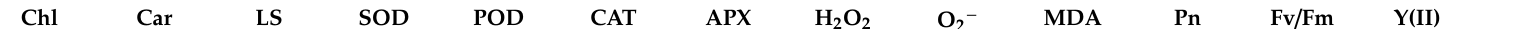
Table 4. Relationships between photosynthetic pigments, leaf senescence, soluble protein, net photosynthetic rate, chlorophyll fluorescence, antioxidant enzymes, reactive oxygen species, and grain yield. Chl Car LS SOD